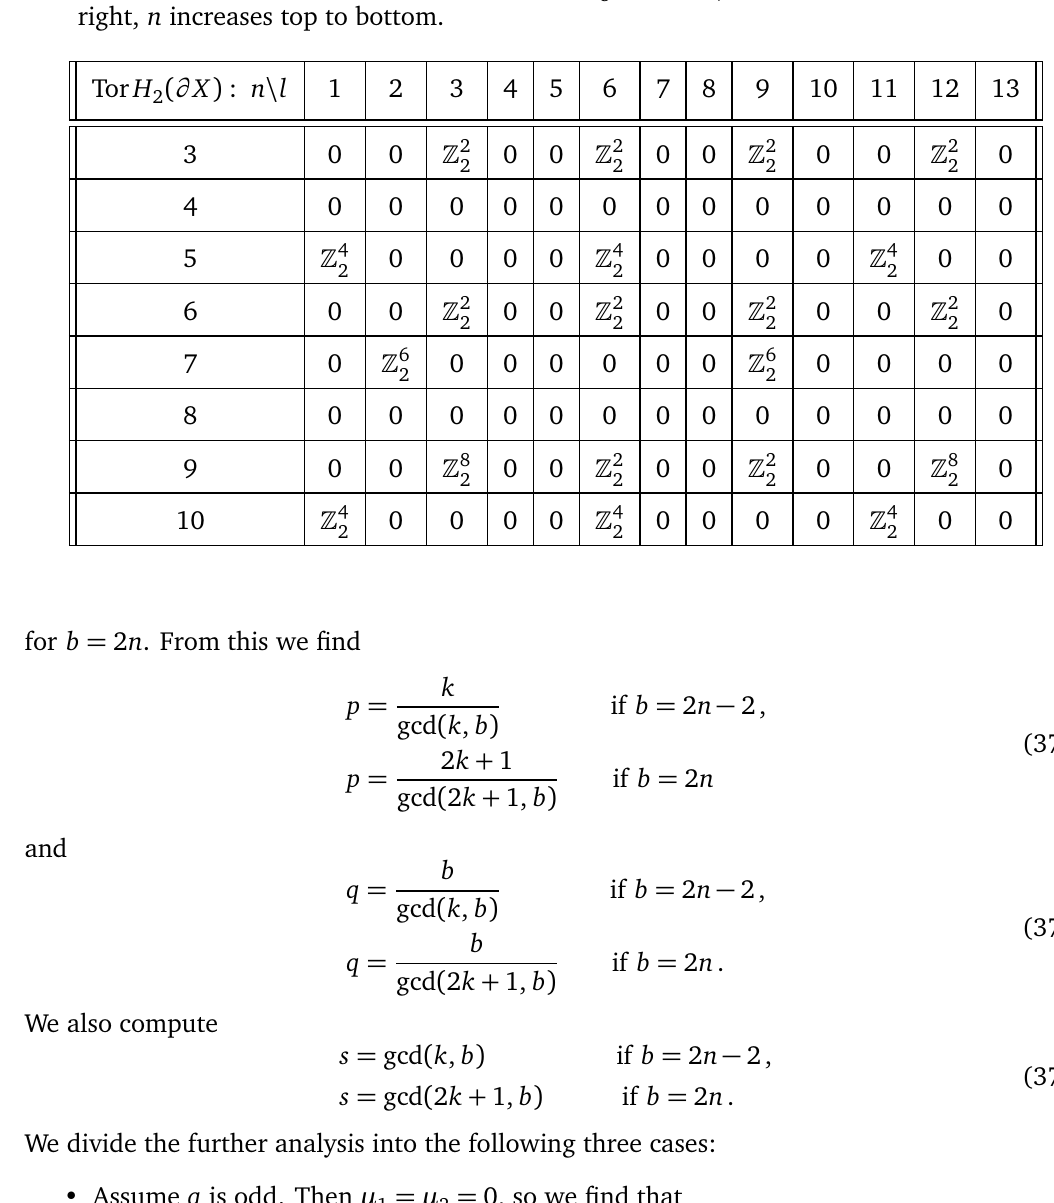
+ x 2 + x n − 1 + x l + 2 = 0. k increase left to x x x 3 4 2 4 1 2 3